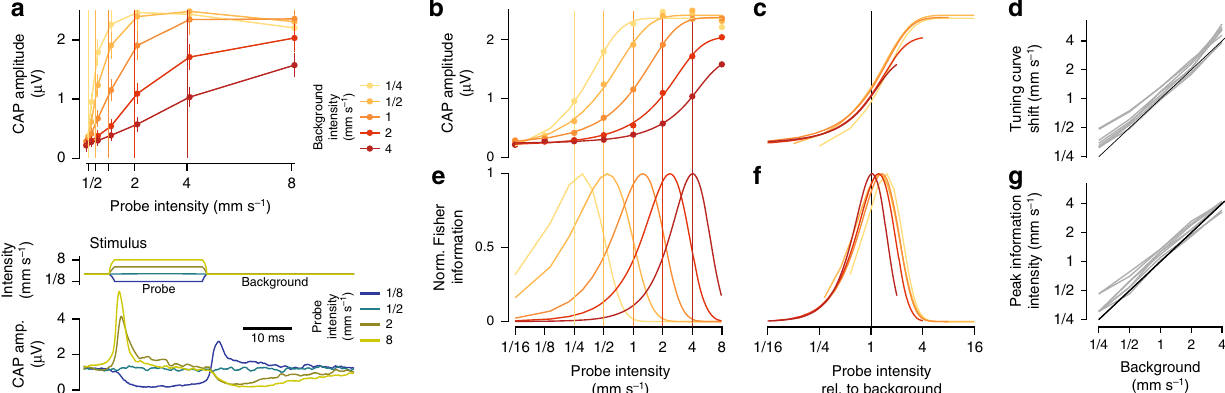
Fig. 2 Variance adaptation in JON is divisive and corrects for background noise. a Intensity tuning curves for JONs adapted to different background stimuli (top, color coded by background intensity; vertical lines mark the background intensity; 40 trials for each background and probe combination). JONs were adapted using a white noise background sound and sound sensitivity was measured using brief, interleaved probe stimuli (amplitude pro fi le of the noise stimulus shown in bottom). On a linear intensity scale, the slope of the tuning curves decreases with background — variance adaptation is thus divisive. Error bars show mean ± 95% CI. b Same as a , but plotted on a logarithmic intensity scale, which transforms the change in slope into a tuning curve shift. Dots correspond to data (error bars omitted for clarity), lines show fi t of sigmoidal curves (see “ Methods ” section for details). c Sigmoidal fi ts from b plotted on a log intensity scale relative to background intensity. Tuning curves overlap, demonstrating that the tuning curve shift is proportional to the background intensity. d Shift of the tuning curves is proportional to background intensity for all N = 5 fl ies ( r 2 = 0.95). The diagonal line corresponds to a perfect match between the tuning curve position and background. All JON tuning curves largely match the diagonal ’ s slope with a weak positive offset. e , f Fisher information curves for the tuning curves in b (normalized to max) show that the discriminability of intensities shifts in proportion to the background intensity ( e — absolute log intensity, f — background-relative log intensity). g The peak intensities for the Fisher information curves shift with background for all N = 5 fl ies ( r 2 = 0.97). Panels a – c and e , f show data from one fl